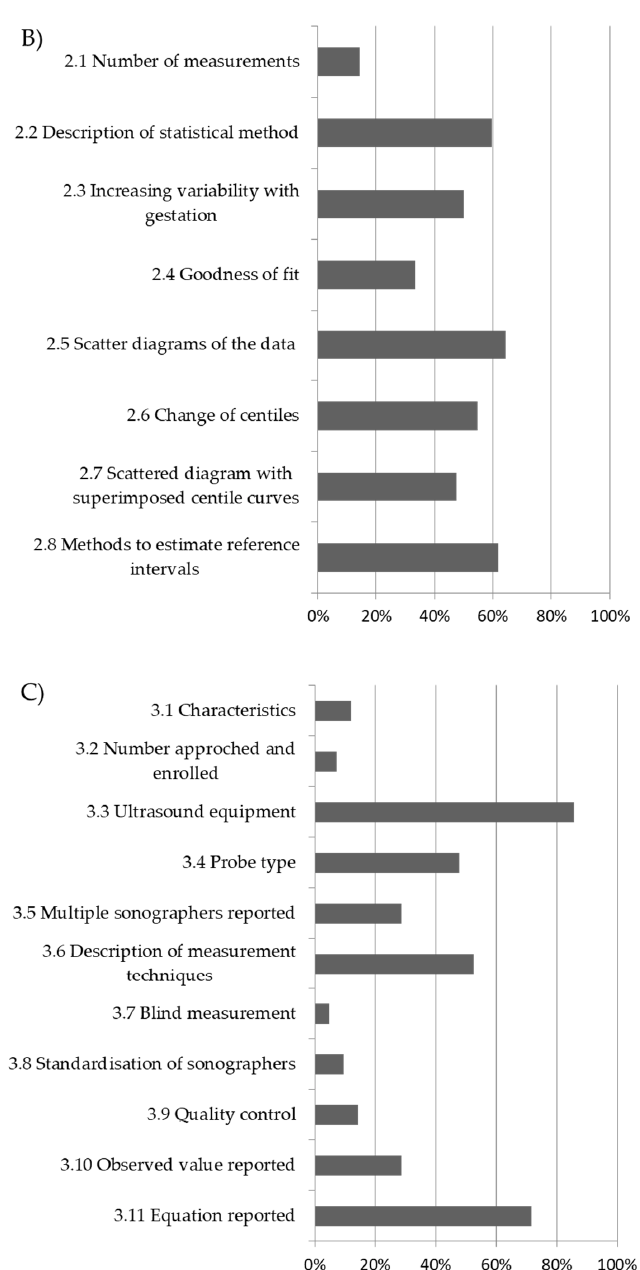
Figure 2. Overall methodological quality of included studies and percentage of low risk of bias: ( A ) study design; ( B ) statistical methods; ( C ) reporting methods. ( A ) study design; ( B ) statistical methods; ( C ) reporting